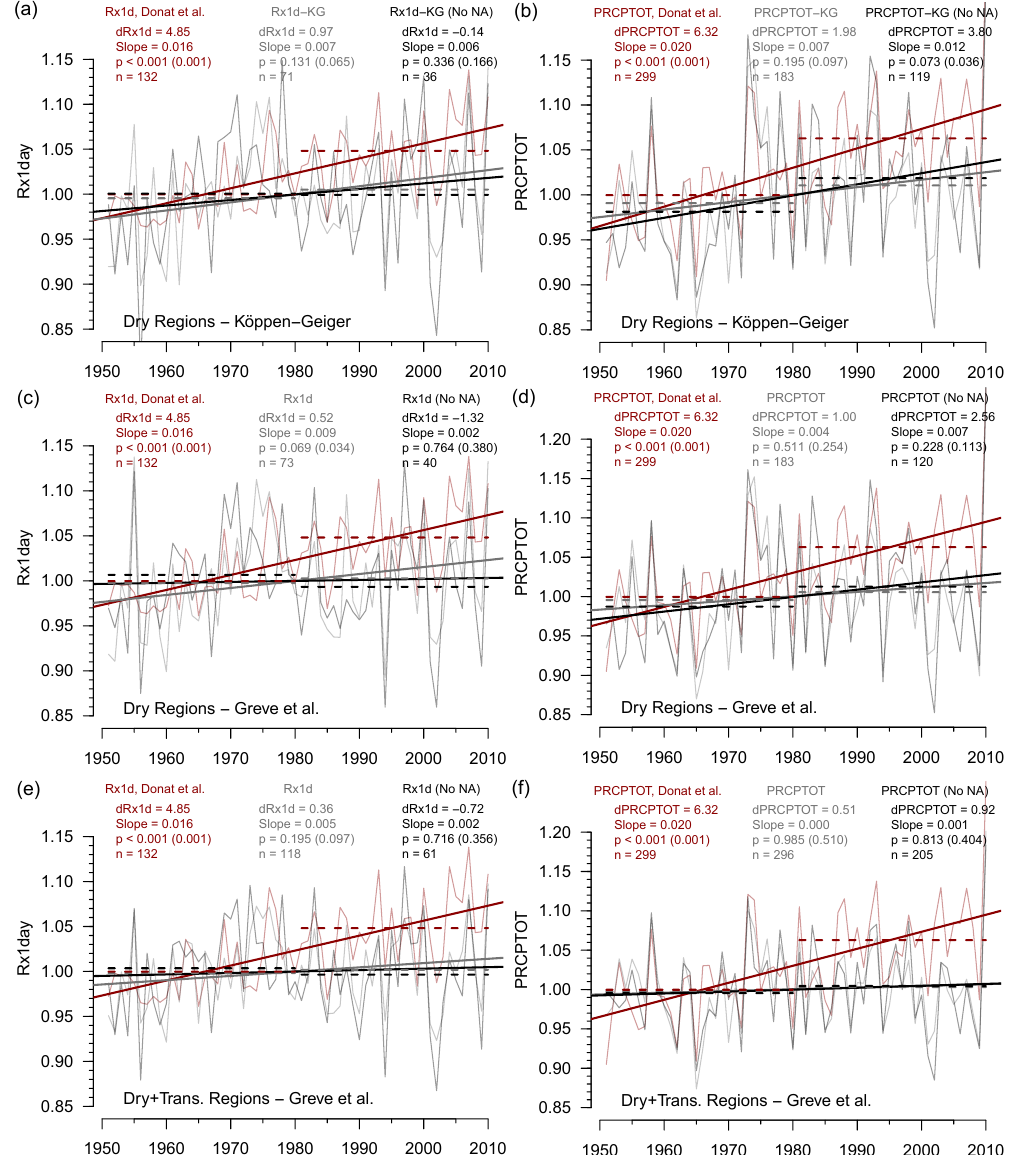
Figure 4. (a) – (f) Time series, trends, and 30-year means of spatially aggregated heavy precipitation (Rx1d, a, c, e ) and annual rainfall totals (PRCPTOT, b, d, f ) in dry regions following (a, b) the Köppen–Geiger classification (Kottek et al., 2006), (c, d) Greve et al. (2014), and (e, f) dry and transitional regions combined (Greve et al., 2014). Red lines are drawn as reported in Donat et al. (2016) for comparison, i.e. based on the 1951–1980 reference period and dryness defined as “moderate extreme precipitation” (Rx1d) and annual precipitation totals (PRCPTOT). Grey and black lines are corrected for statistical artefacts (1951–2010 reference period), and dry regions are defined based on aridity. Grey lines report 90% complete time series, black lines report only data with 100% complete temporal coverage. All p values are given for two-sided (one-sided) Mann–Kendall trend